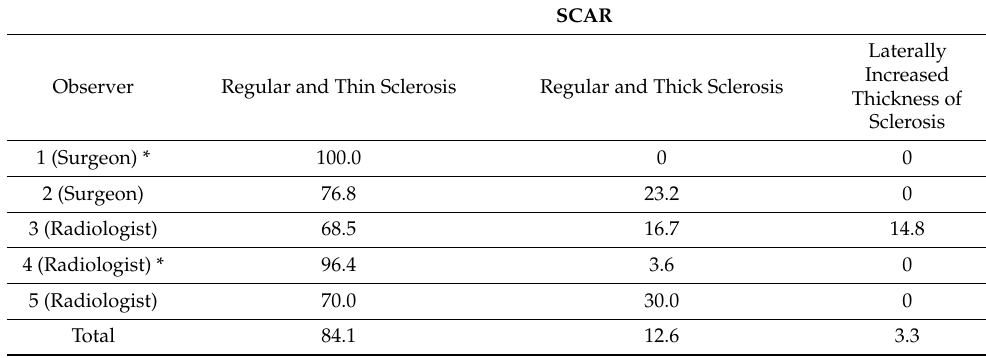
Table 2. Percentage (%) of the diagnosed qualitative values by each observer at four months